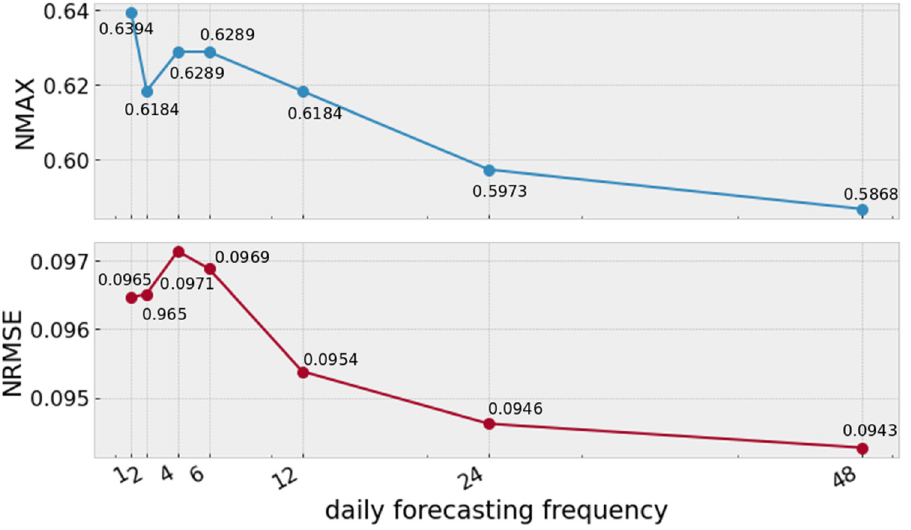
Figure 4. Error metrics on the grid-exchanged power profile (GEPP) for different values of daily forecasting frequency in Scenario 1.